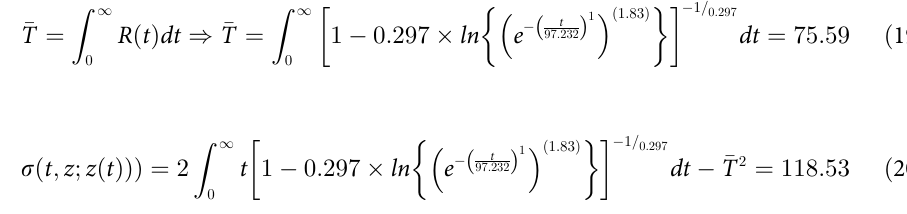
Having σ ( t , z ; z ( t ))) and � T operation time, the number of spare parts required ( M calculated. Here, the estimation is carried out for 365 days, with an average daily operation of 21.5 hours. By considering the probability of a 5% shortage, the required number of spare parts is shown in Fig 4.